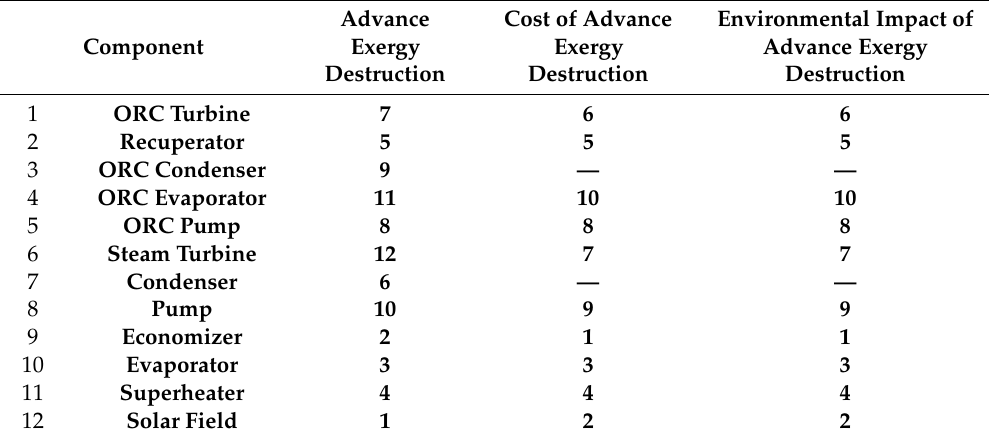
Table 20. Prioritize equipment for optimization in advanced exergy